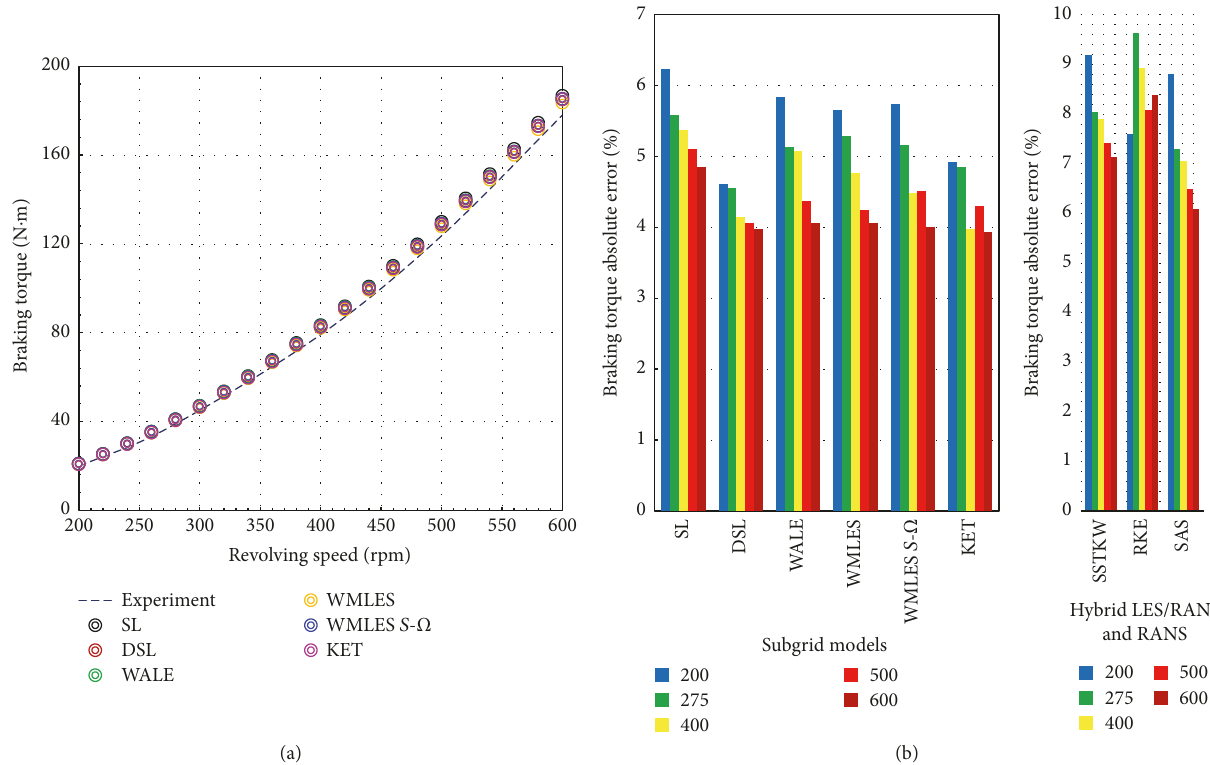
Figure 8: Braking torque calculated results. (a) Experimental and calculated results. (b) Braking torque absolute error.